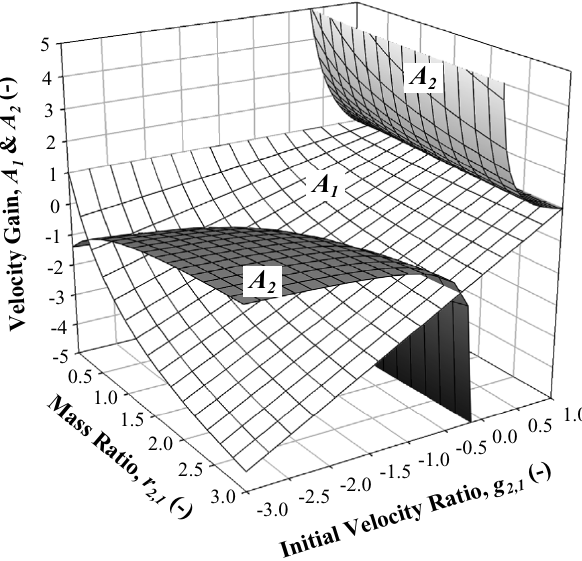
Fig. 2. 3D plot of velocity gain of masses m 1 and m 2 versus mass ratio and initial velocity ratio, for r 2 , 1 = 0 . 8 . (-) means